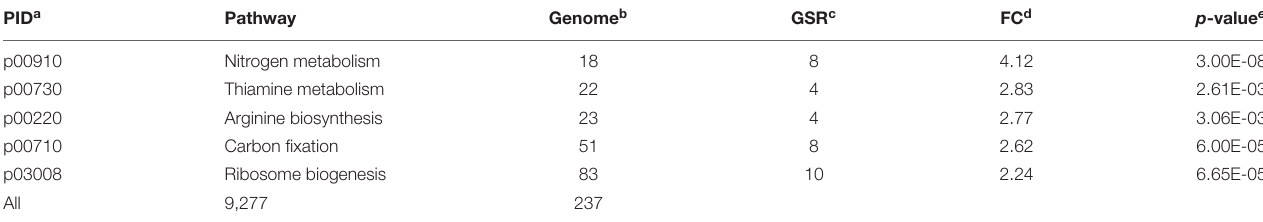
TABLE 1 | Functions enriched in the subset of glucose-specific responsive (GSR) genes.